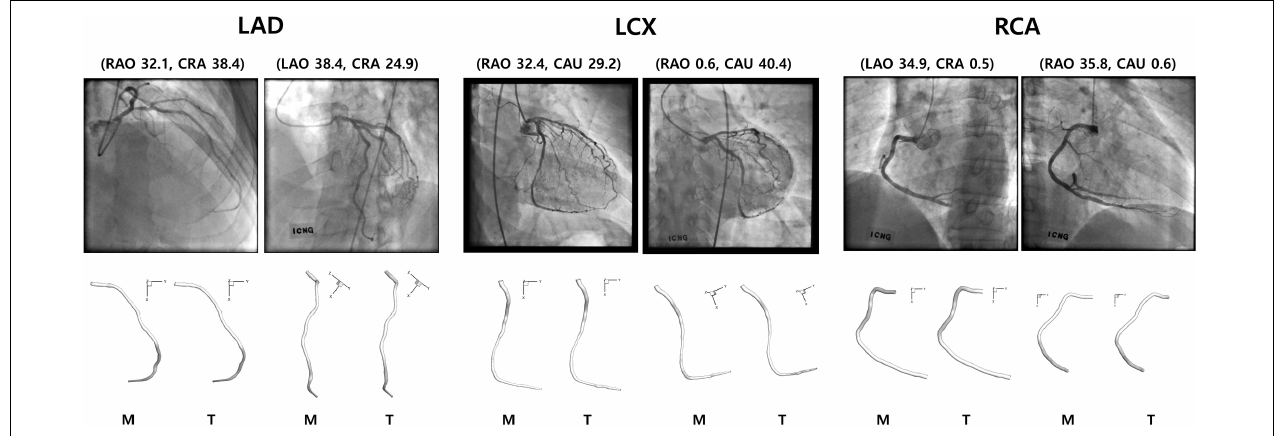
FIGURE 6 | Reconstructed 3-D models for LAD, LCX, and RCA using manual (M) and template (T) matchings.